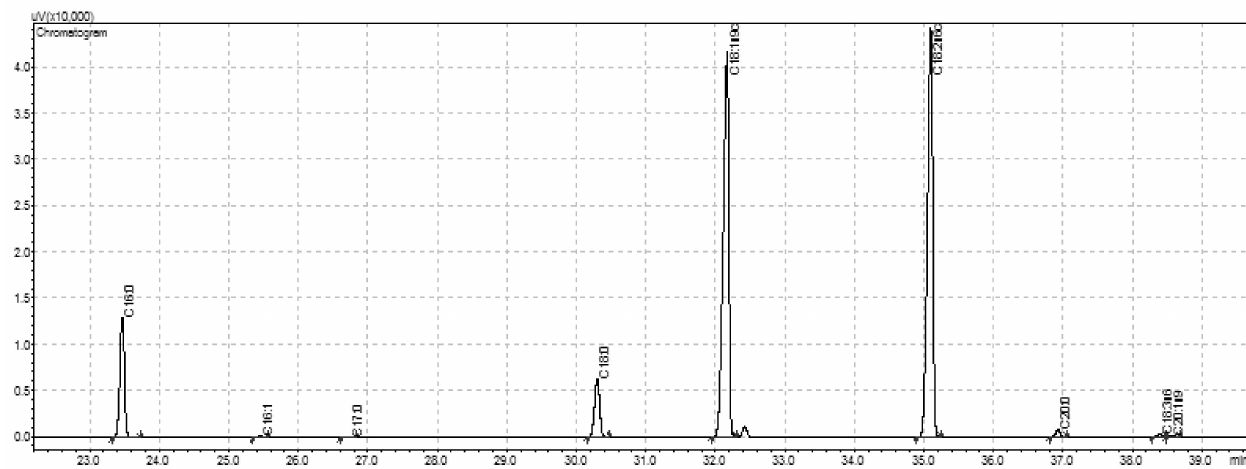
Figure 1. A typical GC-FID (gas chromatography coupled to flame ionization detector) chromatogram obtained for sesame seeds fatty acids profile (C16:0, palmitic; C16:1, palmitoleic; C17:0, margaric; C18:0, stearic; C18:1n9c, oleic; C18:2n6c, linoleic; C20:0, arachidic; C18:3n3, linolenic; C20:1n9, eicosenoic acids), the figure is presented with zoom for better view of the peaks of the fatty acids methyl esters, the analytical run was carried out for 65